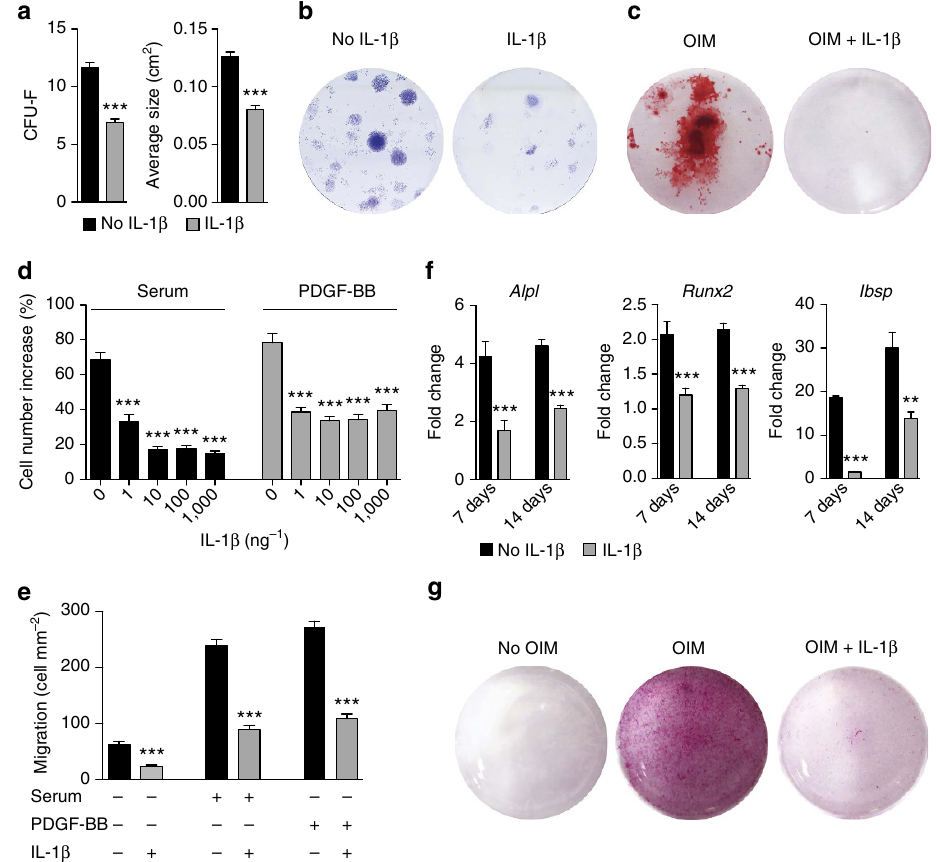
Figure 3 | IL-1 b inhibits c.f.u.-F proliferation migration and osteoblastic differentiation of MSCs. ( a , b ) Primary MSCs were seeded with or without IL-1 b (1ngml (cid:2) 1 during 6 days). Graphs show c.f.u.-F and average size of colonies. Data are means ± s.e.m. ( n ¼ 6 independent isolates). Representative